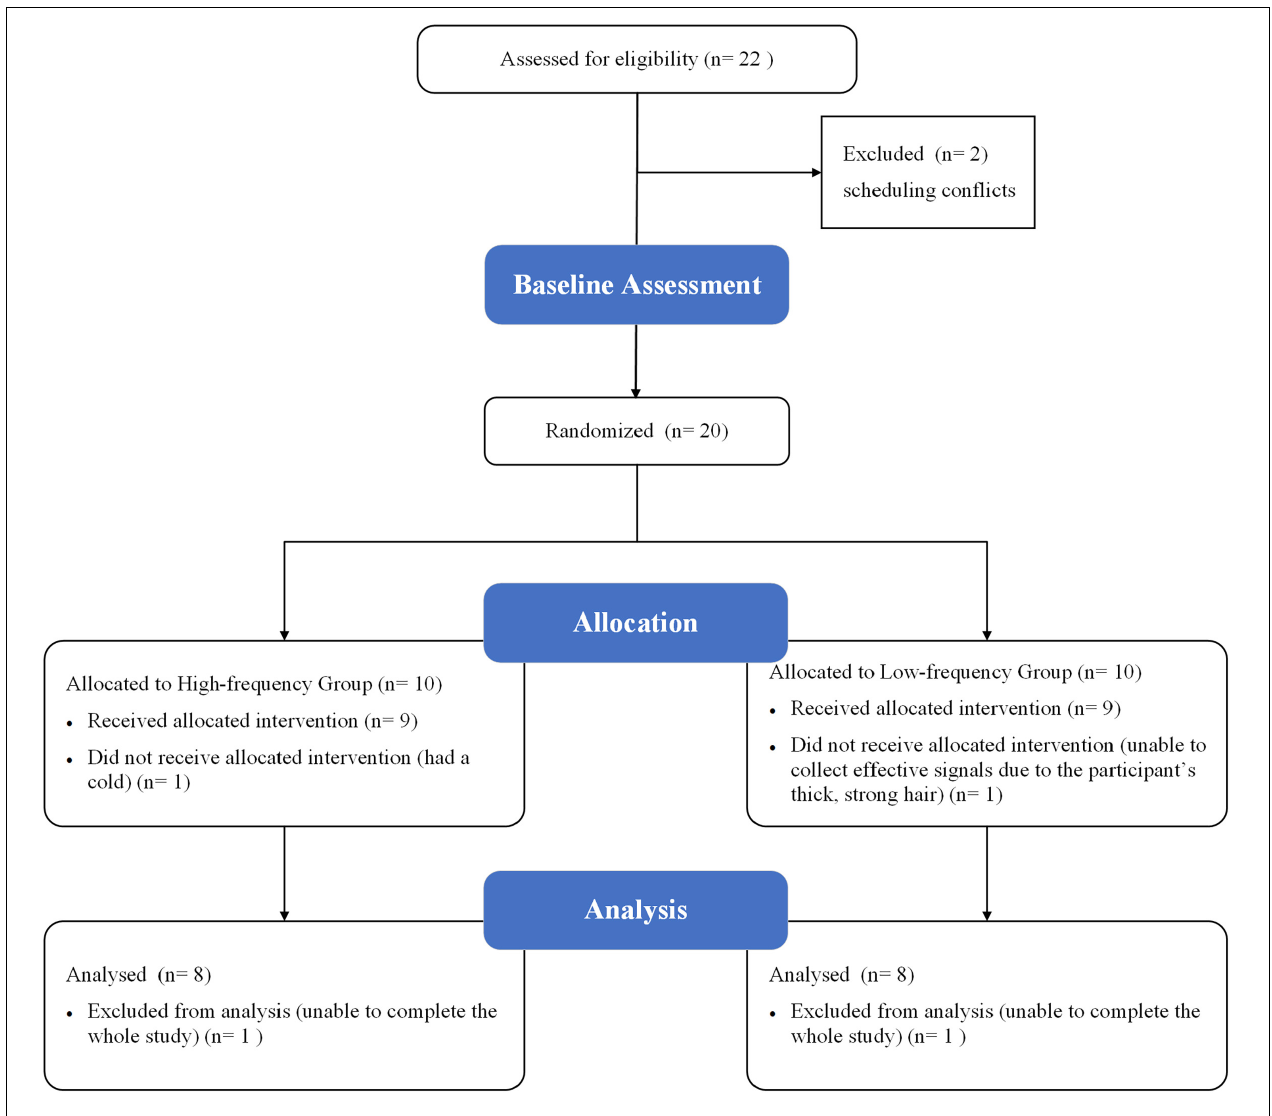
FIGURE 4 | Enrollment